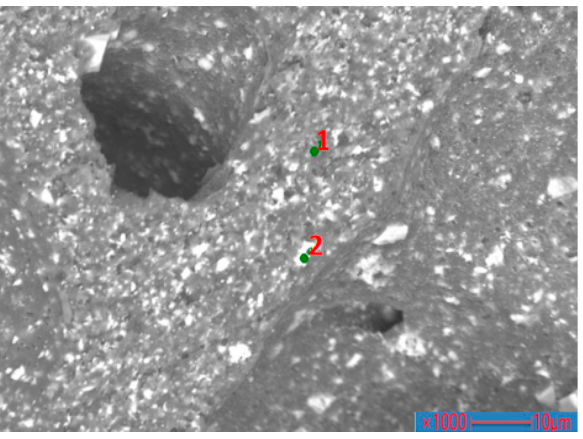
Figure 9. Micro zone analysis of heated PVC film (370 °C) by EPMA: ( 1 ) point 1; ( 2 ) point 2. Table 2. Chemical composition of selected points (at%). Point